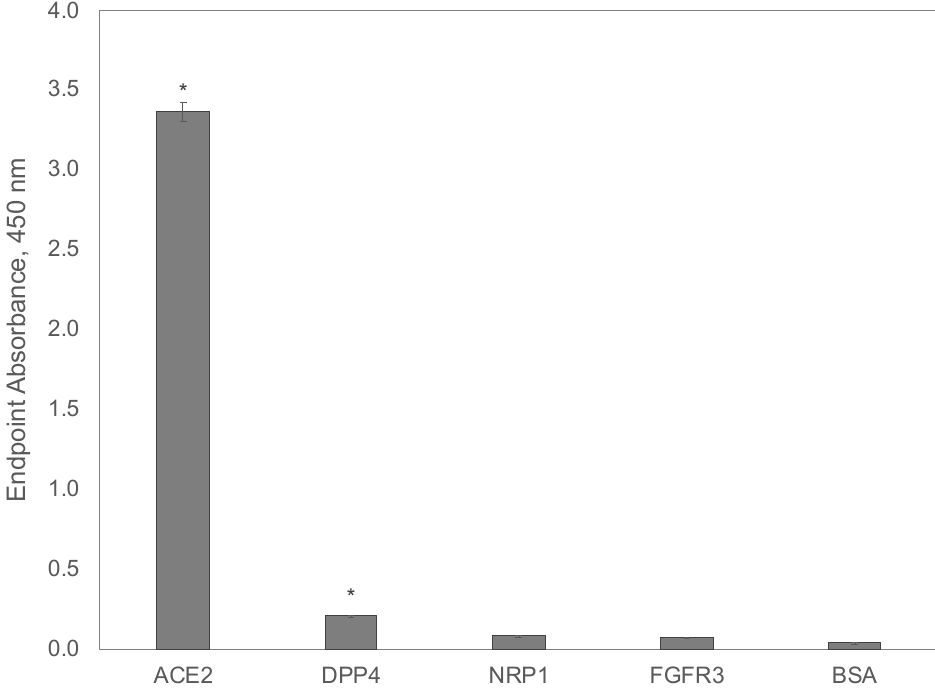
Figure 11. Evaluation of receptors interacting with the SARS-CoV-2 S1 spike protein by an indirect ELISA. Recombinant SARS-CoV-2 S1-His protein was incubated with bound ACE2, DPP4, FGFR3, NRP1, or BSA protein in triplicate wells for 1 h at 37 ◦ C. The wells were incubated with a rabbit anti-SARS-CoV-2 spike IgG and an HRP-conjugated goat anti-rabbit IgG for 1 h at 37 ◦ C. Signal was produced using a TMB substrate and endpoint absorbance at 450 nm was measured after a 30-min incubation. Mean endpoint absorbances for recombinant protein receptors were compared to the means of an unrelated BSA control using a Dunnett’s test with statistically significant differences ( p < 0.05) indicated with a star .